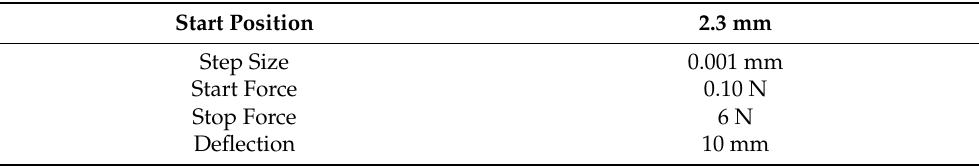
Table 1. Analysis parameter of Nail StrainStress Meter-NM100.